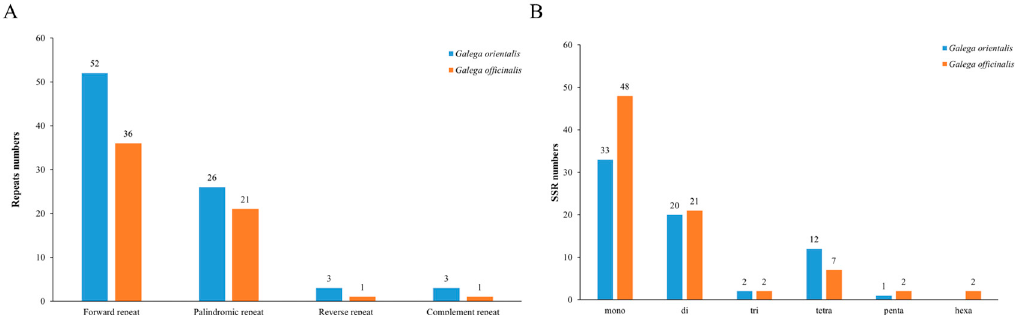
Figure 3. Analysis of repeat sequences in the chloroplast genome of G. orientalis and G. officinalis ( A ). SSR analysis of chloroplast genome of G. orientalis and G. officinalis ( B ). SSRs are highly polymorphic and are valuable tools for genetic diversity studies and analysis of phylogenetic relationships among plant populations. A total of 68 and 82 SSRs (ranging in size from 10 to 24 bp and 10 to 36 bp) were detected in G. orientalis and G. officinalis, respectively. In G. orientalis , the 68 SSRs comprised 33 mono ‐ repeats, 20 di ‐ re ‐ peats, two tri ‐ repeats, 12 tetra ‐ repeats and one penta ‐ repeat. The 82 SSRs in G. officinalis included 48 mono ‐ repeats, 21 di ‐ repeats, two tri ‐ repeats, seven tetra ‐ repeats, two penta ‐ repeats and two hexa ‐ repeats (Figure 3B). Overall, the frequency of mononucleotide re ‐ peats was higher in G. officinalis . In addition, mononucleotide repeats in G. orientalis were predominantly of the A/T motif (96.9%). All dinucleotide repeats were composed of the AT/TA motif. In total, 43 and 21 SSRs were distributed in IGS and CDS regions of G. ori ‐ entalis , respectively (Figure 4A). However, no C/G motif was found in G. officinalis (Figure 4B), but CGTCCA and CTTATA hexanucleotide were found in ycf1 coding gene and clpP ‐ lntron1 , respectively. Notably, the majority of SSRs were found in ycf1 gene in both G. orientalis and G. officinalis (Table S3). Figure 4. The types and distribution of SSRs along the chloroplast genomes of G. orientalis ( A ) and G. officinalis ( B ). Different locations, including CDS, IGS and intron regions, are represented as col ‐ ored boxes. 3.3. Adaptive Evaluation Analysis The Ka/Ks ratio was used to evaluate the degree of selection constraint on each gene and estimate the selective pressure of protein ‐ coding genes. Ka/Ks >1 indicates the gene is under positive selection, Ka/Ks = 1 indicates the gene is under neutral selection and Ka/Ks <1 indicates purification selection.